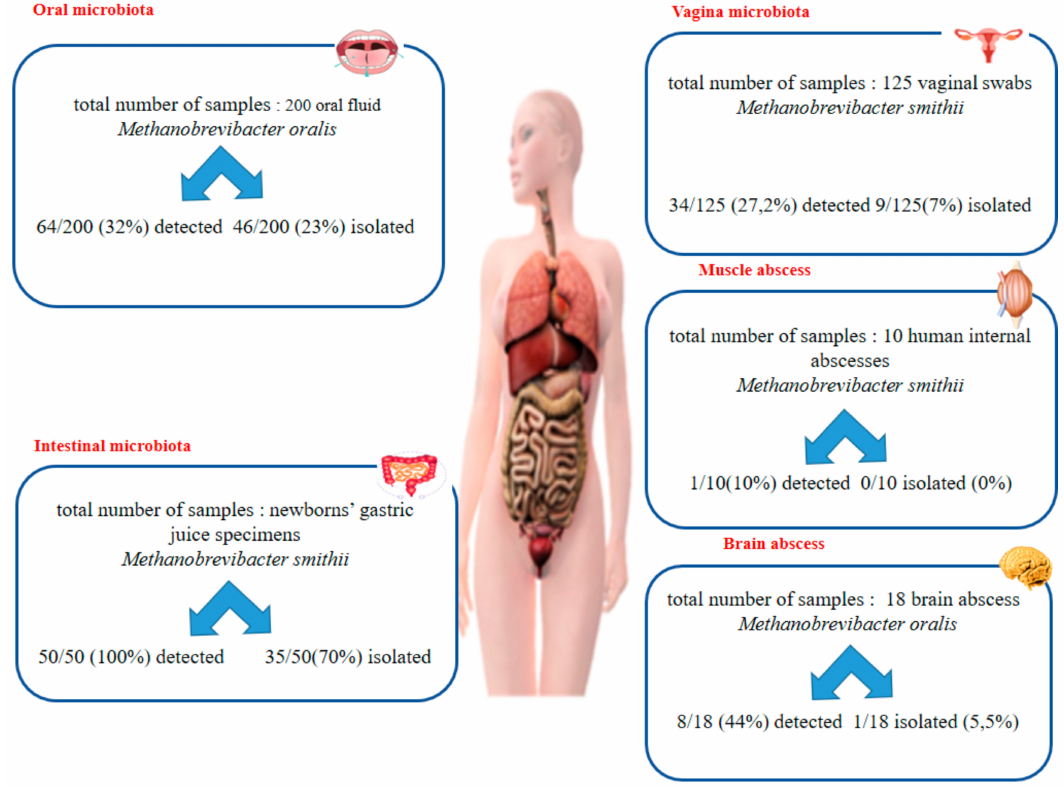
Figure 1. The comparative results of PCR detection and culture detection in di ff erent human